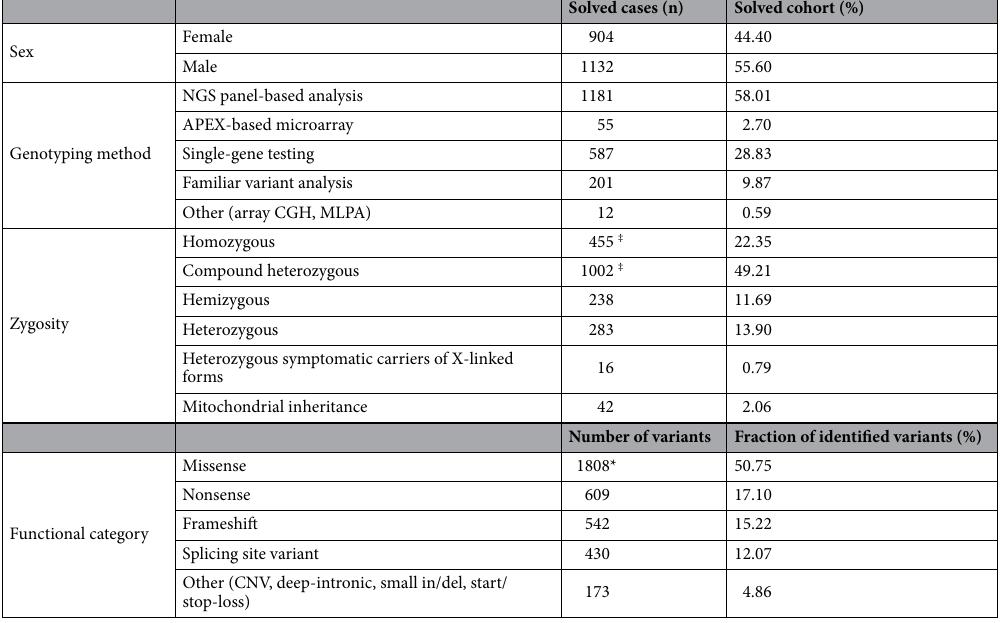
Table 2. Overview of the genetically solved cohort. *ACMG classification of missense variants (according to VarSome, ClinVar, LOVD): 61% Pathogenic, 22% Likely Pathogenic, 17% VUS. ‡ Homozygosity and compound heterozygosity was confirmed by segregation analysis in 14.1% and 12.1% of cases,